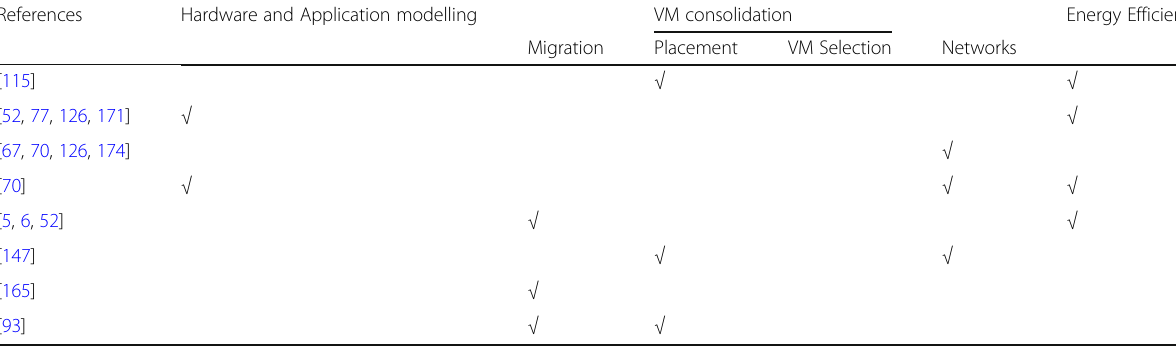
Table 5 Analysis of the existing survey papers in the literature Hardware and Application